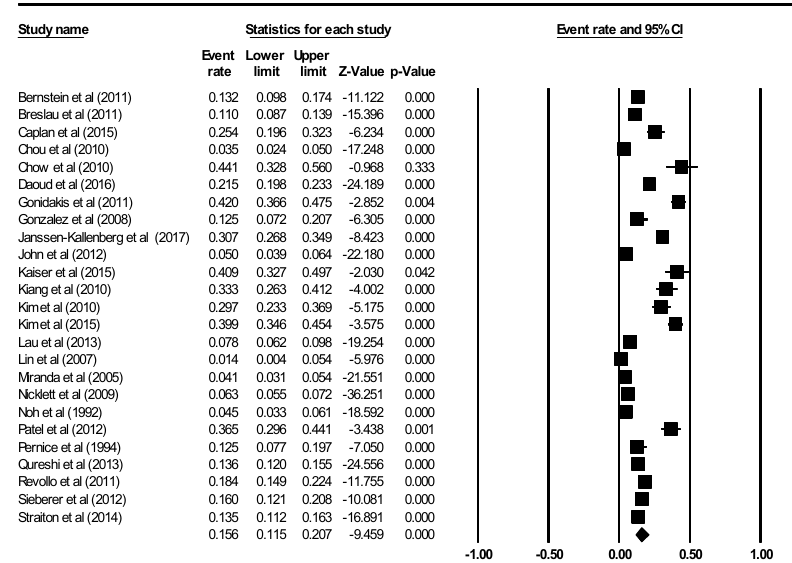
Figure 2. Forest plot of aggregate prevalence of depression among migrants using data from all 25 included studies. Table 1. Results for meta-regression analysis.